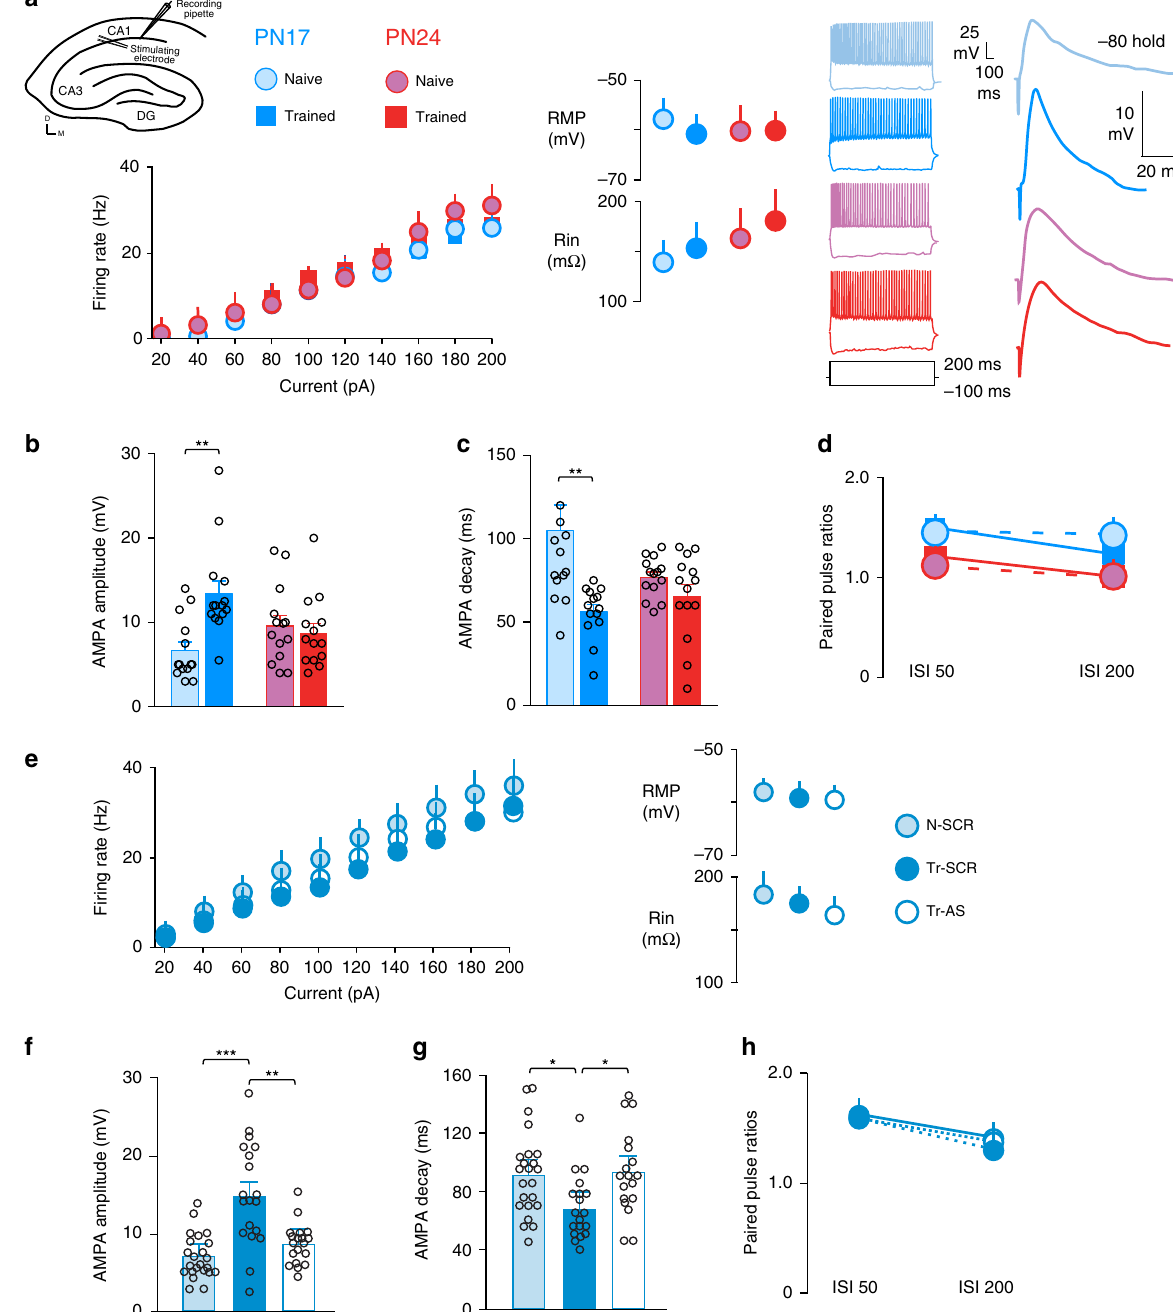
Fig. 3 Learning-induced changes in AMPA receptor responses at PN17 require the expression of PSD-95. a Diagram shows where whole-cell recordings were carried out in hippocampal slice preparations, and where a biphasic stimulator was placed to evoke AMPAergic responses. From left to right: intrinsic excitability data showing the effect of training at PN17 or PN24 on fi ring rate, resting membrane potential and membrane input resistance, representative traces of hippocampal pyramidal neurons following positive and negative current injection into the cell, and representative traces from the same cells showing evoked AMPA receptor potentials. b , c AMPA receptor potential amplitude ( b ) and decay time ( c ) after training at PN17 and PN24. d Paired-pulse ratios after training at PN17 and PN24. Sample size for a – d , each group, n = 14 cells obtained from three male rats per age. ** P < 0.01 (two-way ANOVA followed by Bonferroni ’ s multiple comparisons test). e Recordings were obtained from naive (N) and trained (Tr) rats, which received two hippocampal injections of scrambled (SCR) or PSD-95-antisense ODN (AS), the fi rst immediately after training at PN17 and the second 6 h later. Rats were euthanized 24 h after training (i.e., PN18). These recordings were conducted in slices immediately in front of and behind the slice containing the cannula implant site. From left to right: Intrinsic excitability data showing the effect of training at PN17 and PSD-95 AS-ODN injections on fi ring rate, resting membrane potential, and membrane input resistance. f , g The effect of PSD-95 AS-ODN or SCR-ODN injections following training at PN17 on AMPA receptor potential amplitude ( f ) and decay time ( g ). h The effect of PSD-95 AS-ODN or SCR-ODN injections following training at PN17 on paired-pulse ratios. Sample size for e – h , N-SCR, n = 23 cells; Tr-SCR, n = 19 cells; Tr-AS, n = 18 cells; obtained from three male rats per group. * P < 0.05, ** P < 0.01, *** P < 0.01 (one-way ANOVA followed by Tukey ’ s multiple comparisons test). For detailed statistical information, see Supplementary Tables 5 –